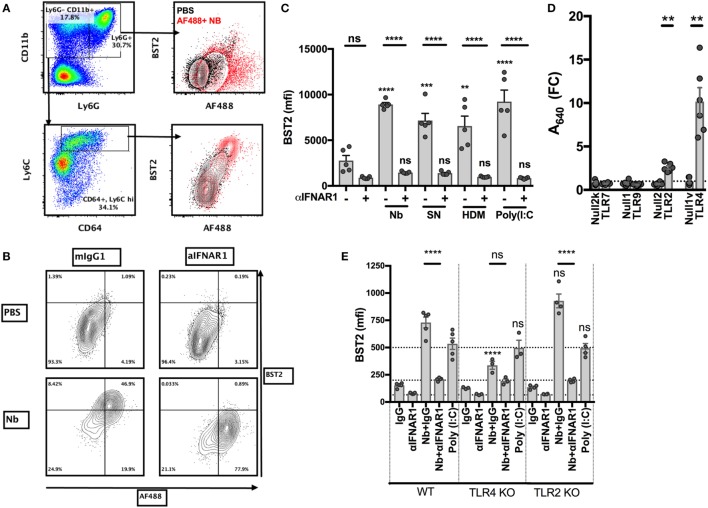
Toll-like receptor 4 (TLR4) expression is necessary for Nippostrongylus brasiliensis (Nb)-dependent BST2 expression in vitro. Bone marrow (BM) cells were harvested from C57BL/6 mice or the indicated strains, stimulated overnight in the described conditions, and analyzed by flow cytometry. (A) Identification of neutrophils (CD11bhi Ly6G+) and monocytes (CD11bhi Ly6G− Ly6C+) and their uptake of AF488 and expression of BST2 after stimulation with AF488+ Nb (red) or medium (black). (B) BST2 expression on monocytes from BM cultures that were stimulated with AF488+ Nb in the presence of IFNAR1-blocking antibodies or isotype control. (C) BST2 expression on monocytes from BM cultures stimulated with Nb, Nb supernatant (SN), house dust mite (HDM) or Poly(I:C) in the presence of IFNAR1-blocking antibodies or mIgG1. Data are from one of at least two independent experiments that gave similar results; each dot corresponds to a BM culture from a separate mouse. (D) Stimulation of TLR reporter activity by Nb. Cell lines expressing the indicated TLR and their respective controls were cocultured overnight with Nb or no stimulus, and TLR reporter activity was quantified using a colorimetric assay. Reporter activity for each cell line is expressed as fold-change (FC) of the readings for stimulated versus unstimulated cultures. Each dot corresponds to an independent experiment and is the average of triplicate cultures. (E) BM cells from C57BL/6 (WT), TLR4 KO or TLR2 KO mice were cultured with Nb or Poly(I:C) or no stimulus, in the presence of IFNAR1-blocking antibodies or isotype control. BST2 expression on monocytes was assessed after overnight culture. Data are from one of at least two independent experiments that gave similar results; each dot corresponds to a BM culture from a separate mouse. Statistical analyses used the ANOVA with Tukey’s multiple comparisons test. NS: not significant; **p < 0.01, ***p < 0.001, ****p < 0.0001. Symbols above individual bars refer to the p value of the indicated group versus its control condition, which was either unstimulated (C) or WT (E).